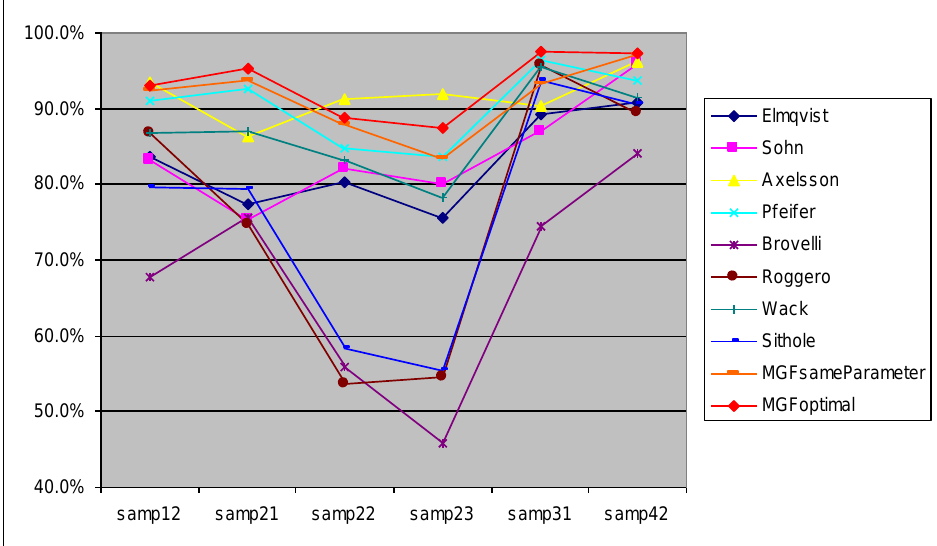
Figure 5. Accuracies of nine ground filters on relative flat urban sites that contain objects with various size and